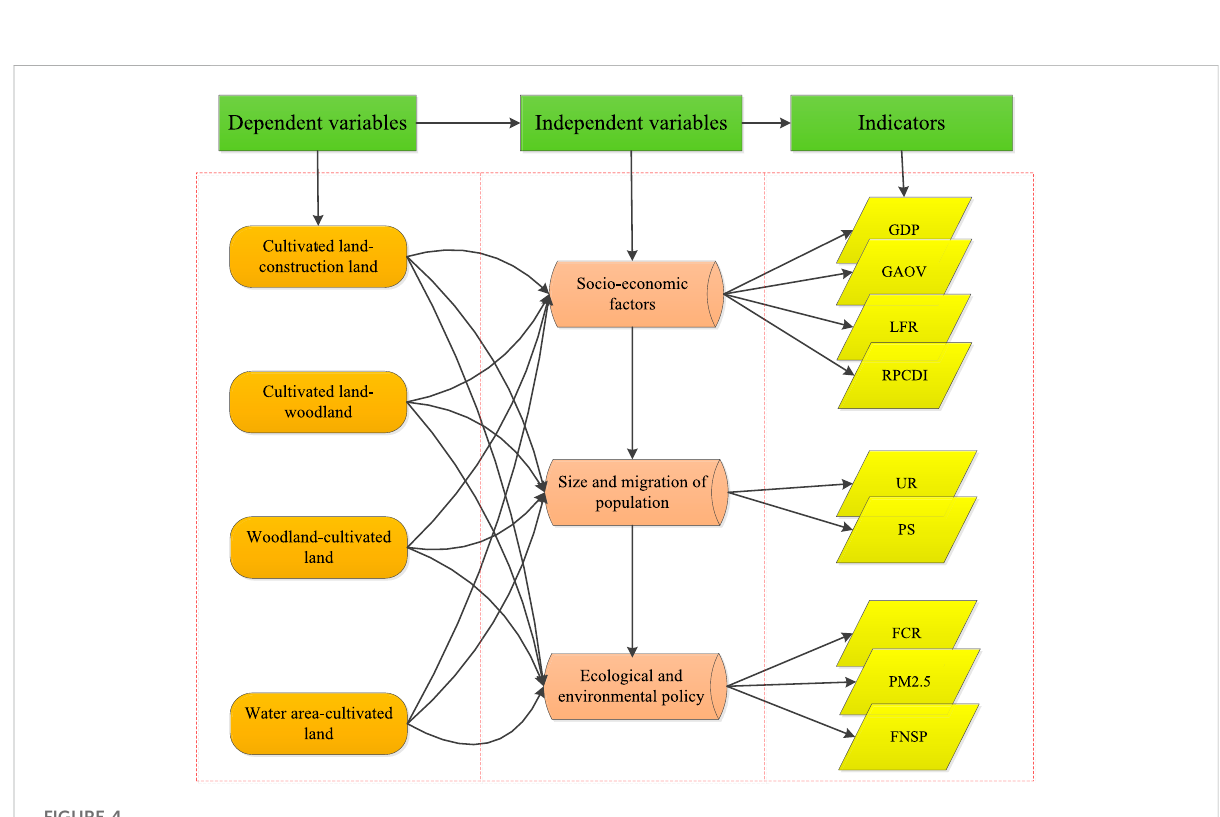
FIGURE 4 Indicator frameworks in the present